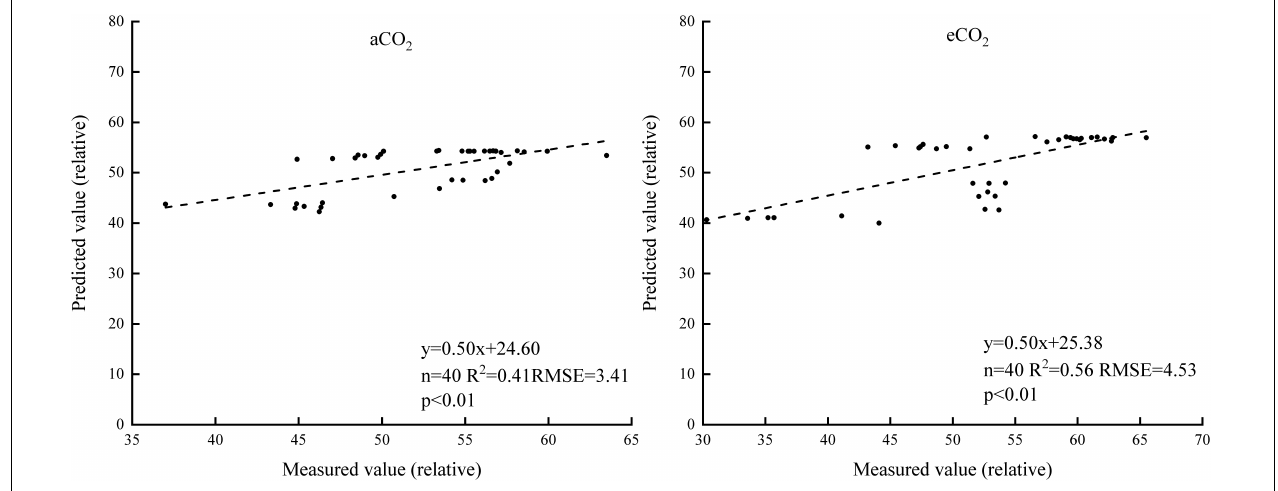
FIGURE 3 | The measured and estimated values of the chlorophyll content based on the red-edge position model under aCO 2 and eCO 2 .